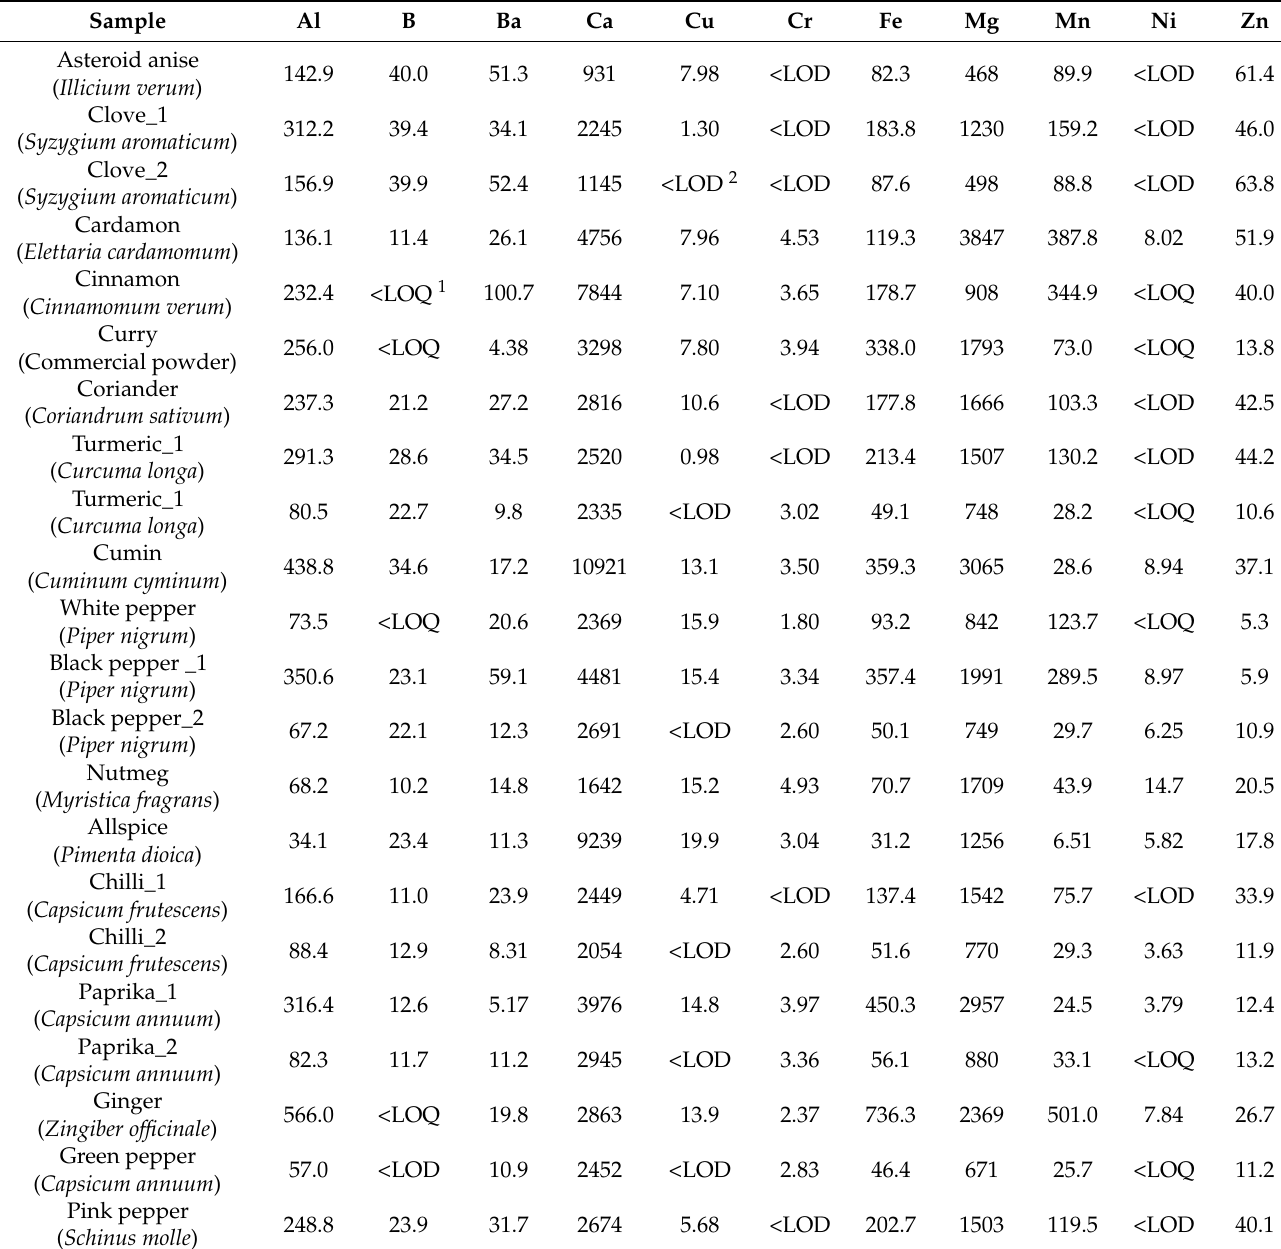
Table 3. Elemental composition of the examined samples. Each value is the average obtained from duplicate analysis of the examined